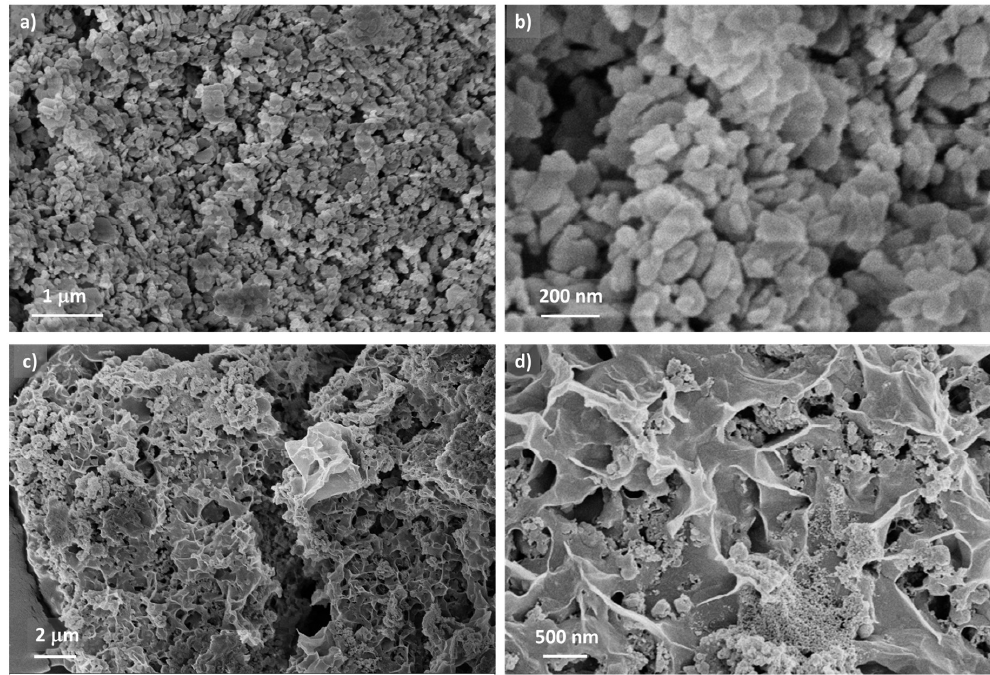
Figure 5. Morphology of H1_CTAB ( a , b ) and Ce@H1_CTAB(W) ( c , d ).